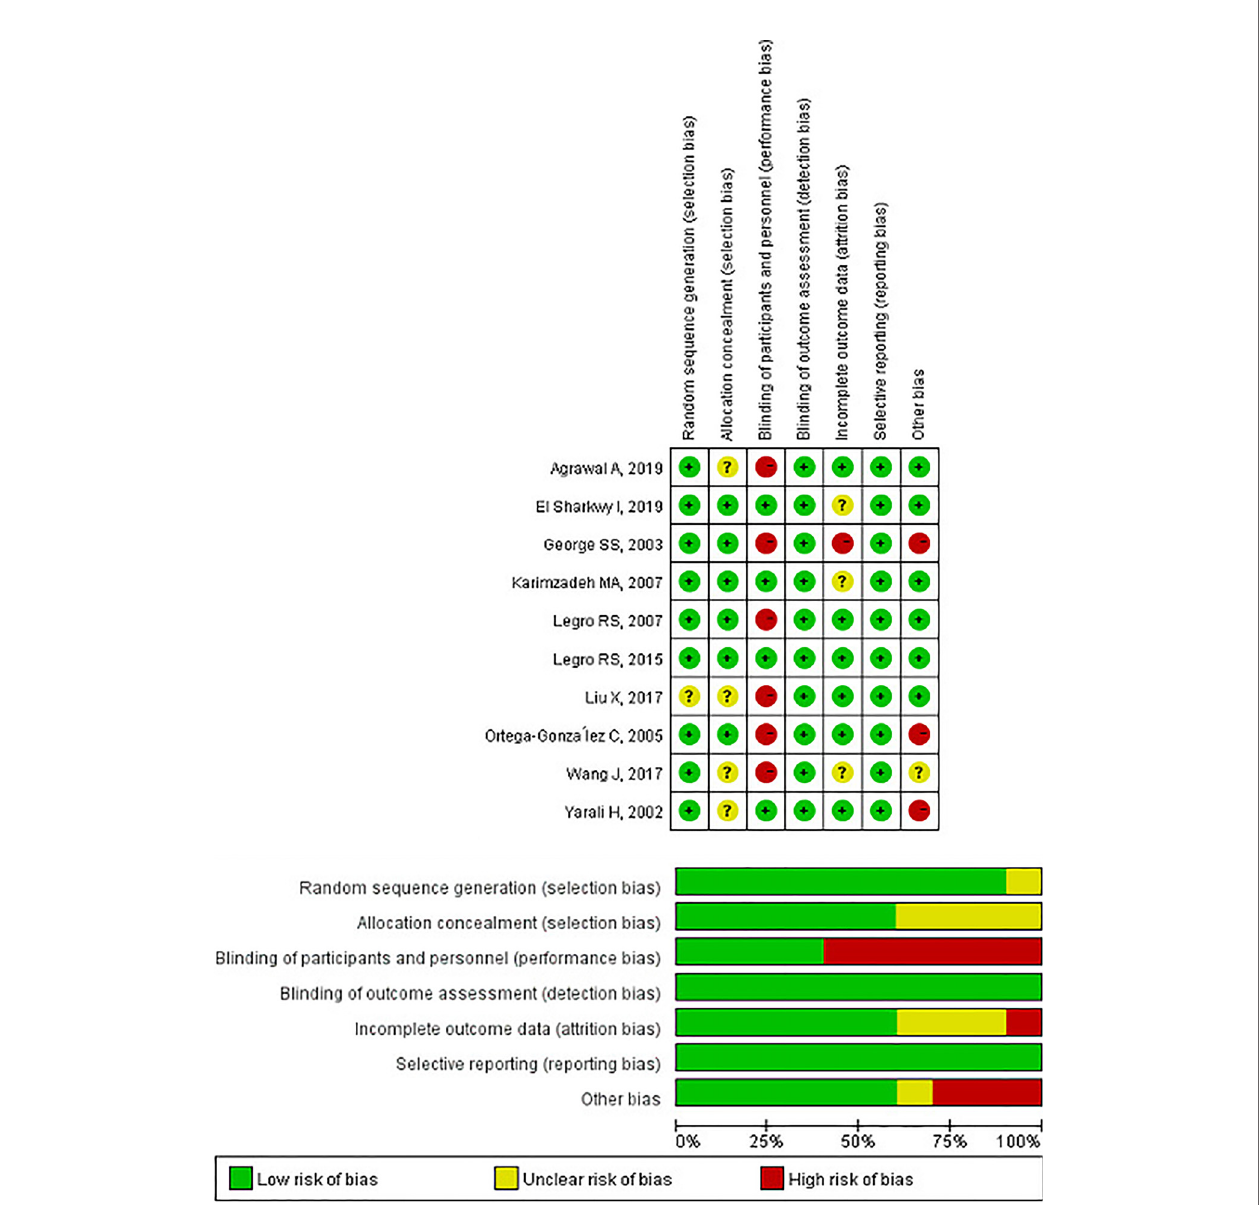
FIGURE 2 | The cochrane collaboration risk of bias evaluation for the included